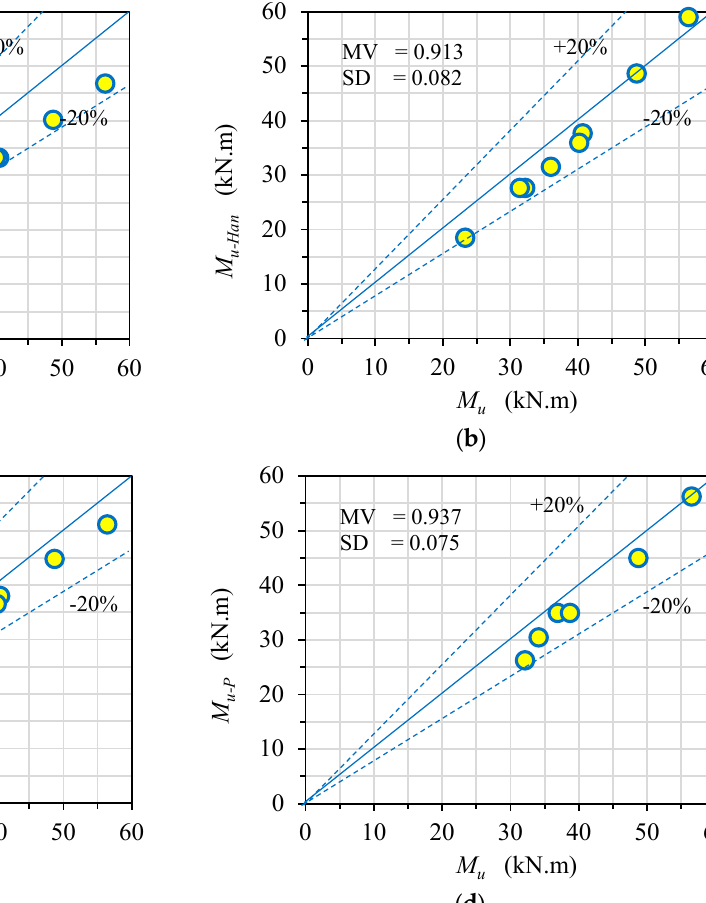
Figure 19. Verification of the obtained results with the predicted values using different methods. ( a ) EC4-2004; ( b ) Han-2004; ( c ) Al Zand-2020; and ( d ) Al Zand-2018 (with CFRP).